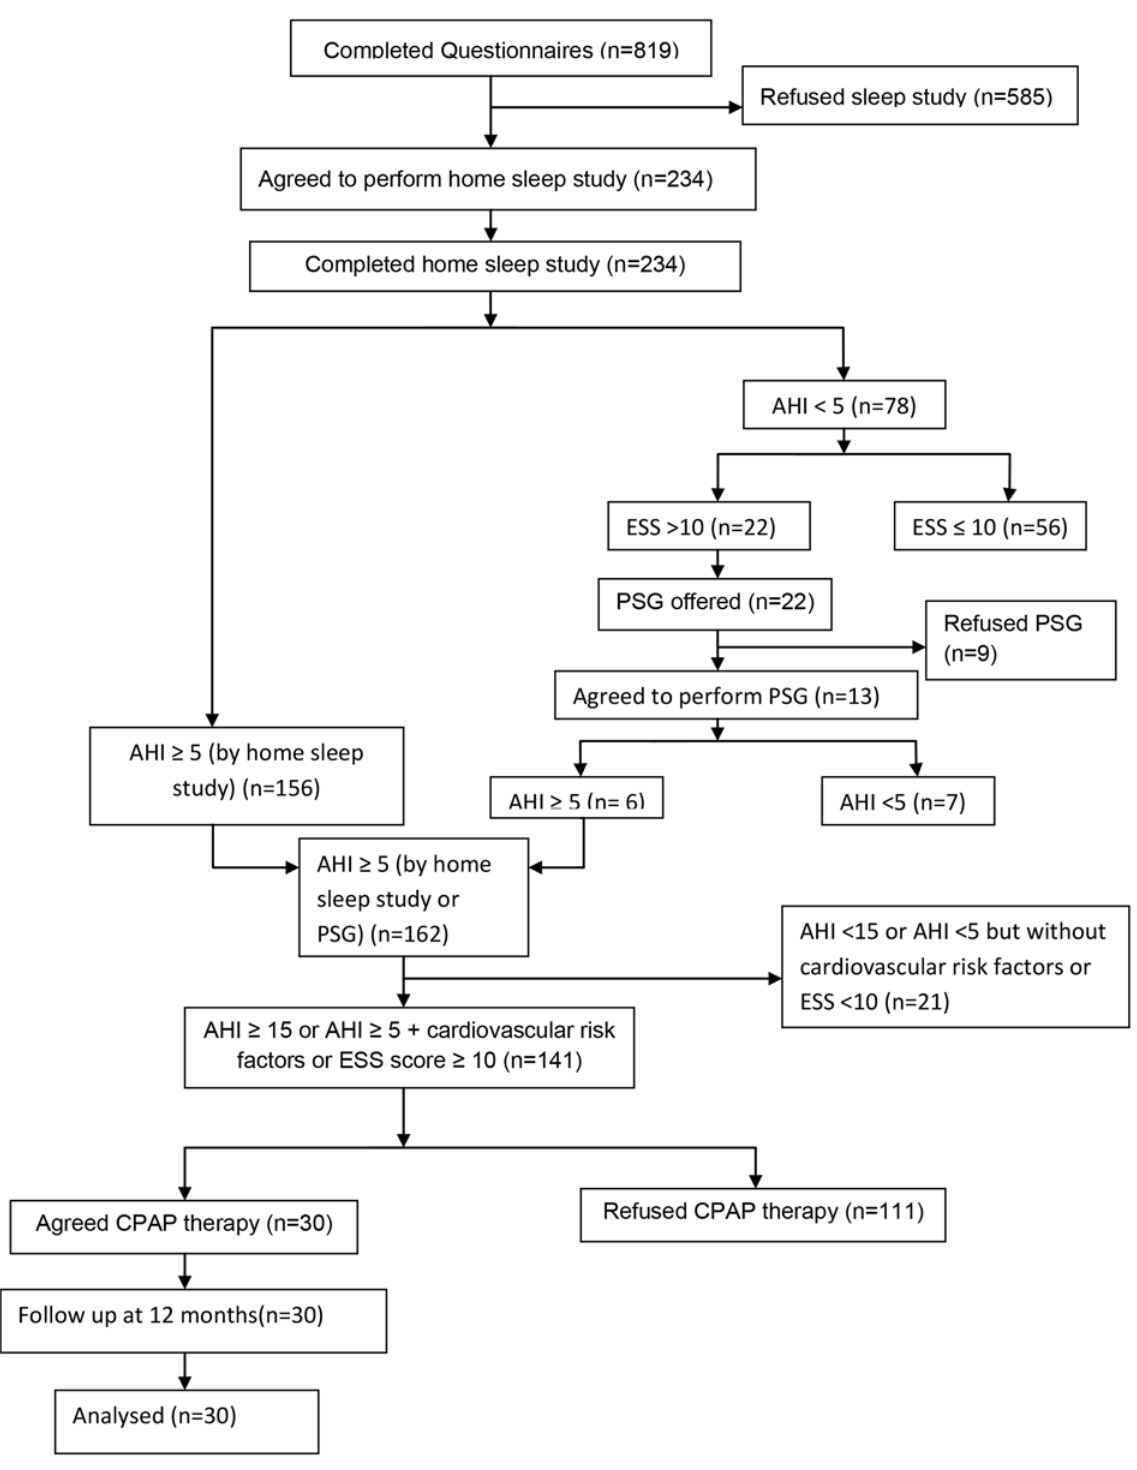
Fig 1. Study flow chart. AHI = apnea hypopnea index. CPAP = Continuous positive airway pressure. ESS = Epworth Sleepiness Score. PSG = polysomnography.